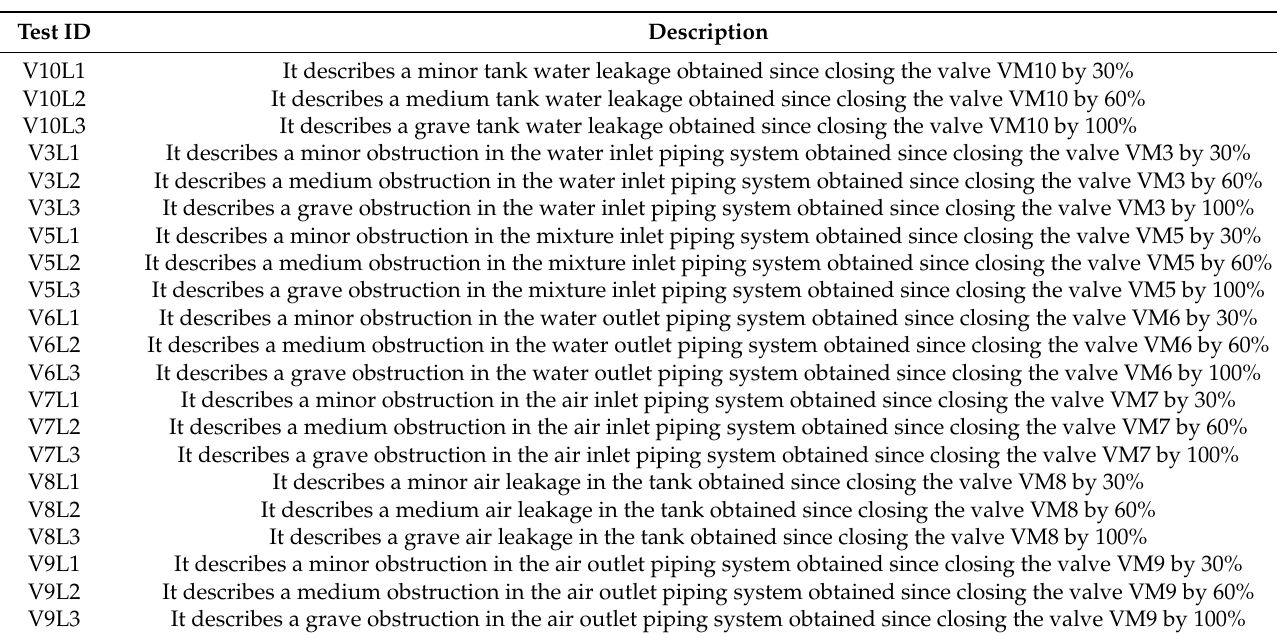
Table 3. Description of the